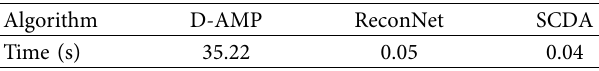
Table 11: The number of network parameters for 10 images (the measurement rate is 0.05).